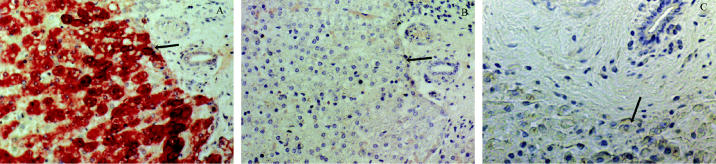
CYP1A1 expression in liver from beluga whale. CYP1A1 is labeled pink to dark red; arrows indicate cells with labeling and the identical cell type without labeling. (A) CYP1A1 expression in hepatic parenchyma from an Arctic beluga. (B) Serial section from Arctic beluga shown in (A) stained using the nonspecific antibody UPC-10. (C) CYP1A1 expression in hepatic parenchyma from a St. Lawrence beluga. Magnification, 400×.